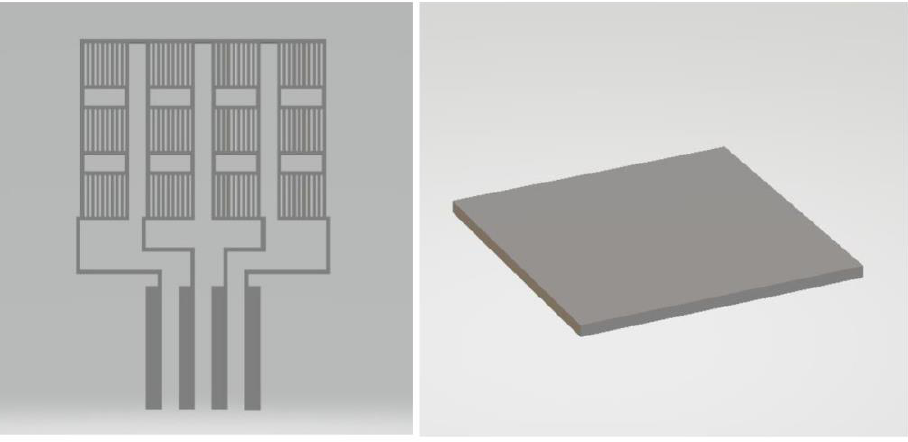
Figure 18. Principle of structural models.